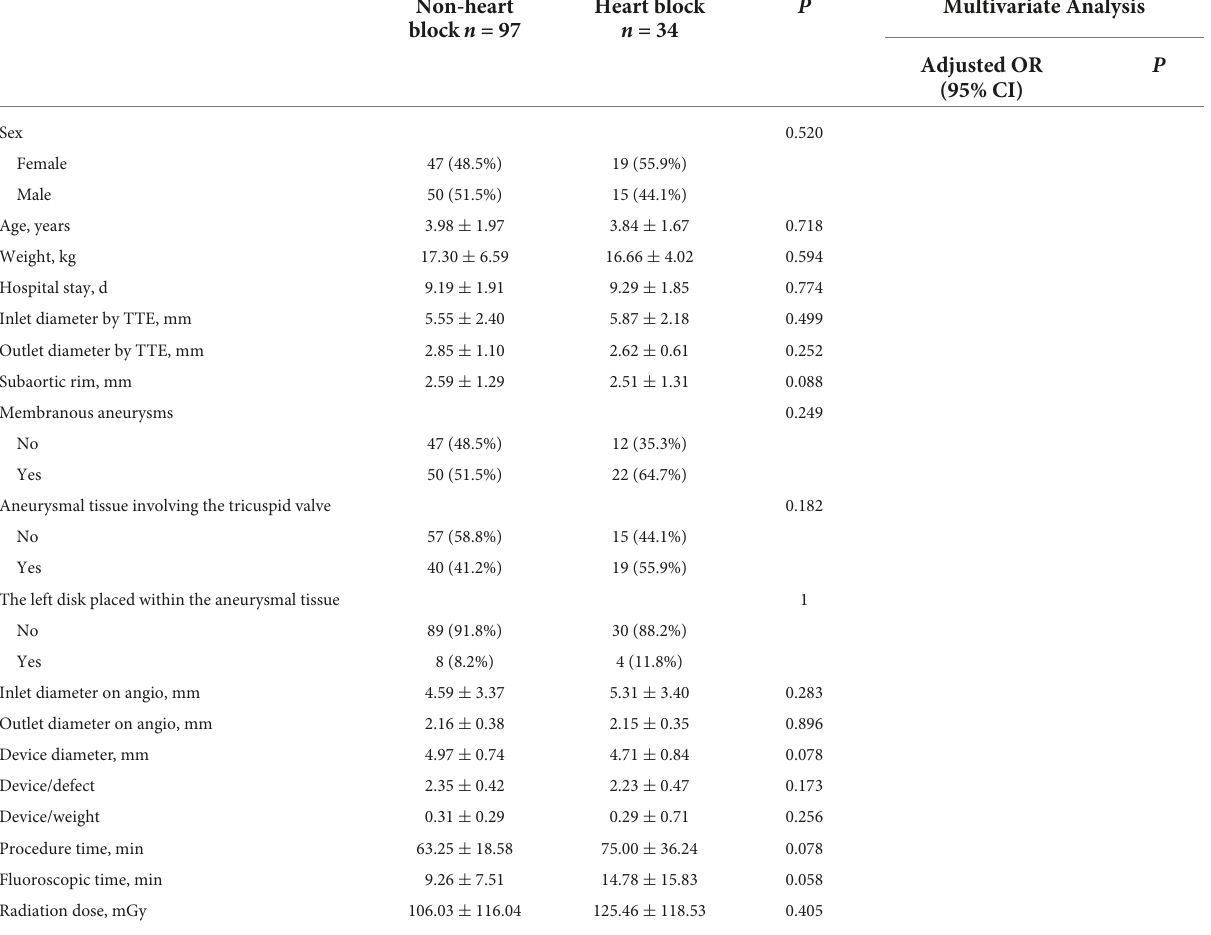
TABLE 9 Risk factors for occurrence of heart block in patients using Amplatzer Duct Occluder II (ADO II).